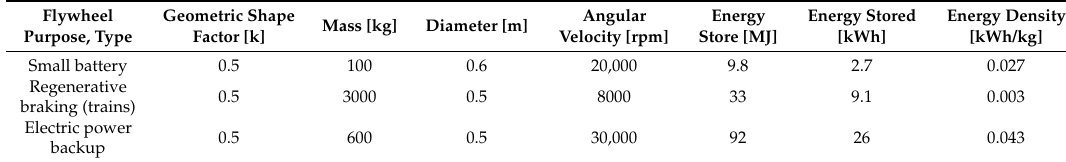
Table 8. Flywheel Uses and Specifications